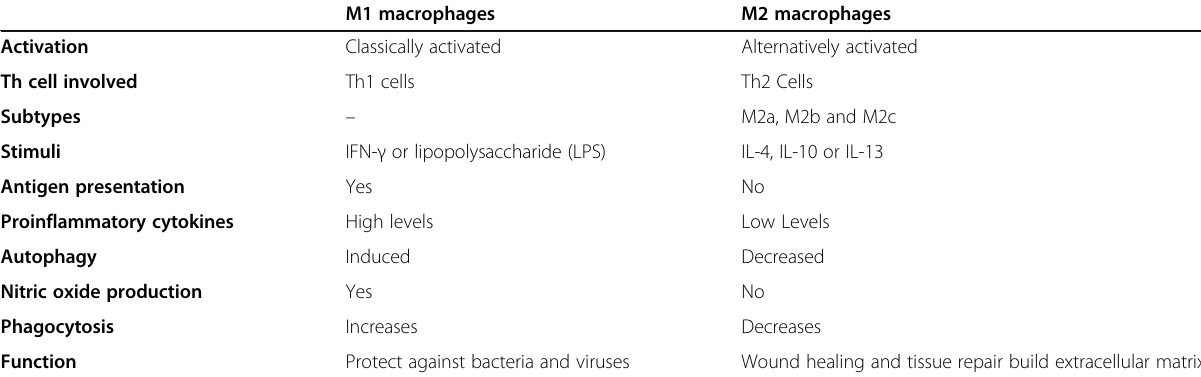
Table 1 Difference between M1 and M2 macrophages